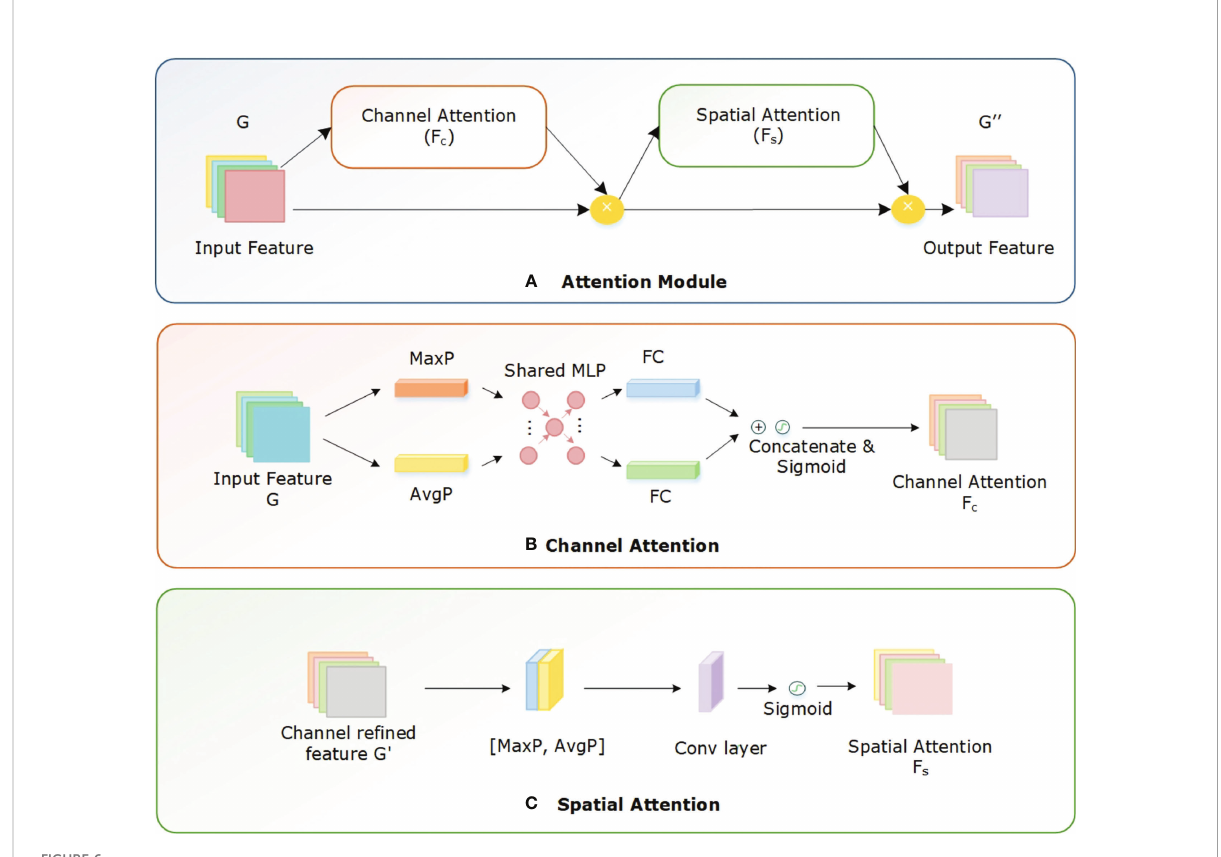
FIGURE 6 Structure of Attention module comprising channel and spatial